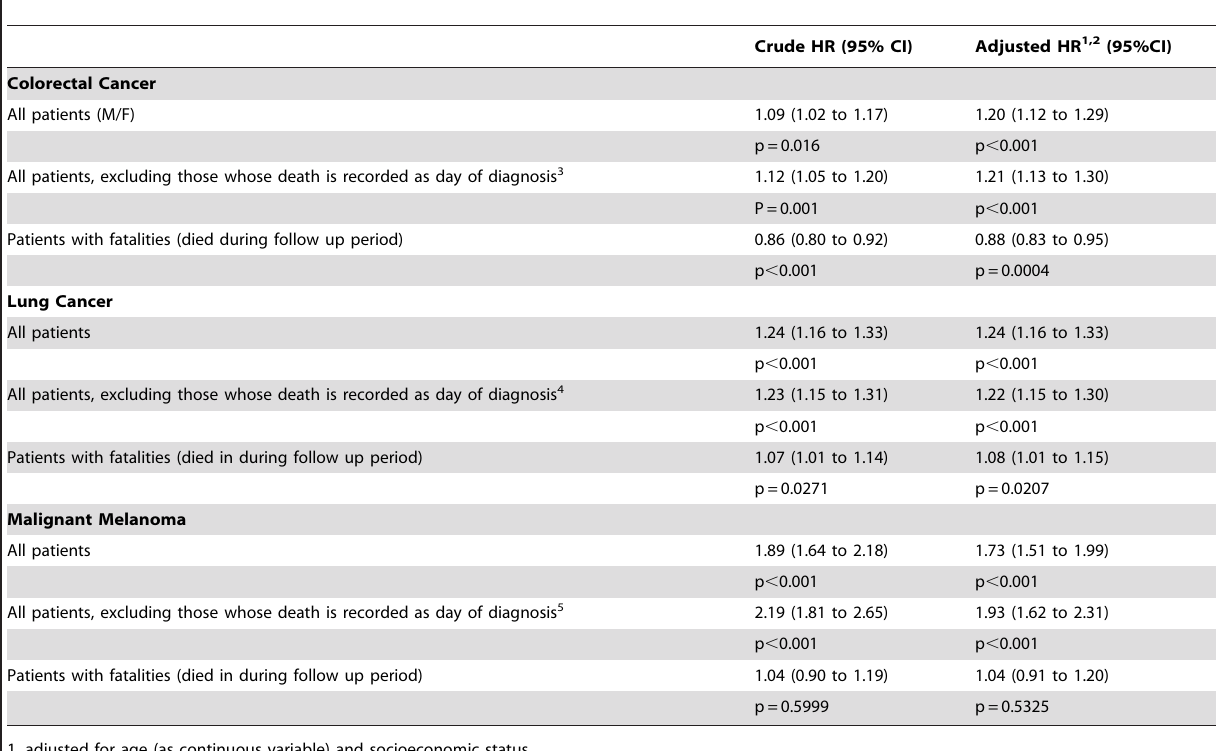
Table2. Estimation of the relative hazard of death for patients with colorectal cancer, lung cancer and malignant melanoma, diagnosed